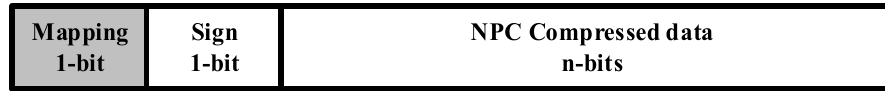
Figure 3. Total output format of NPC algorithm unit.